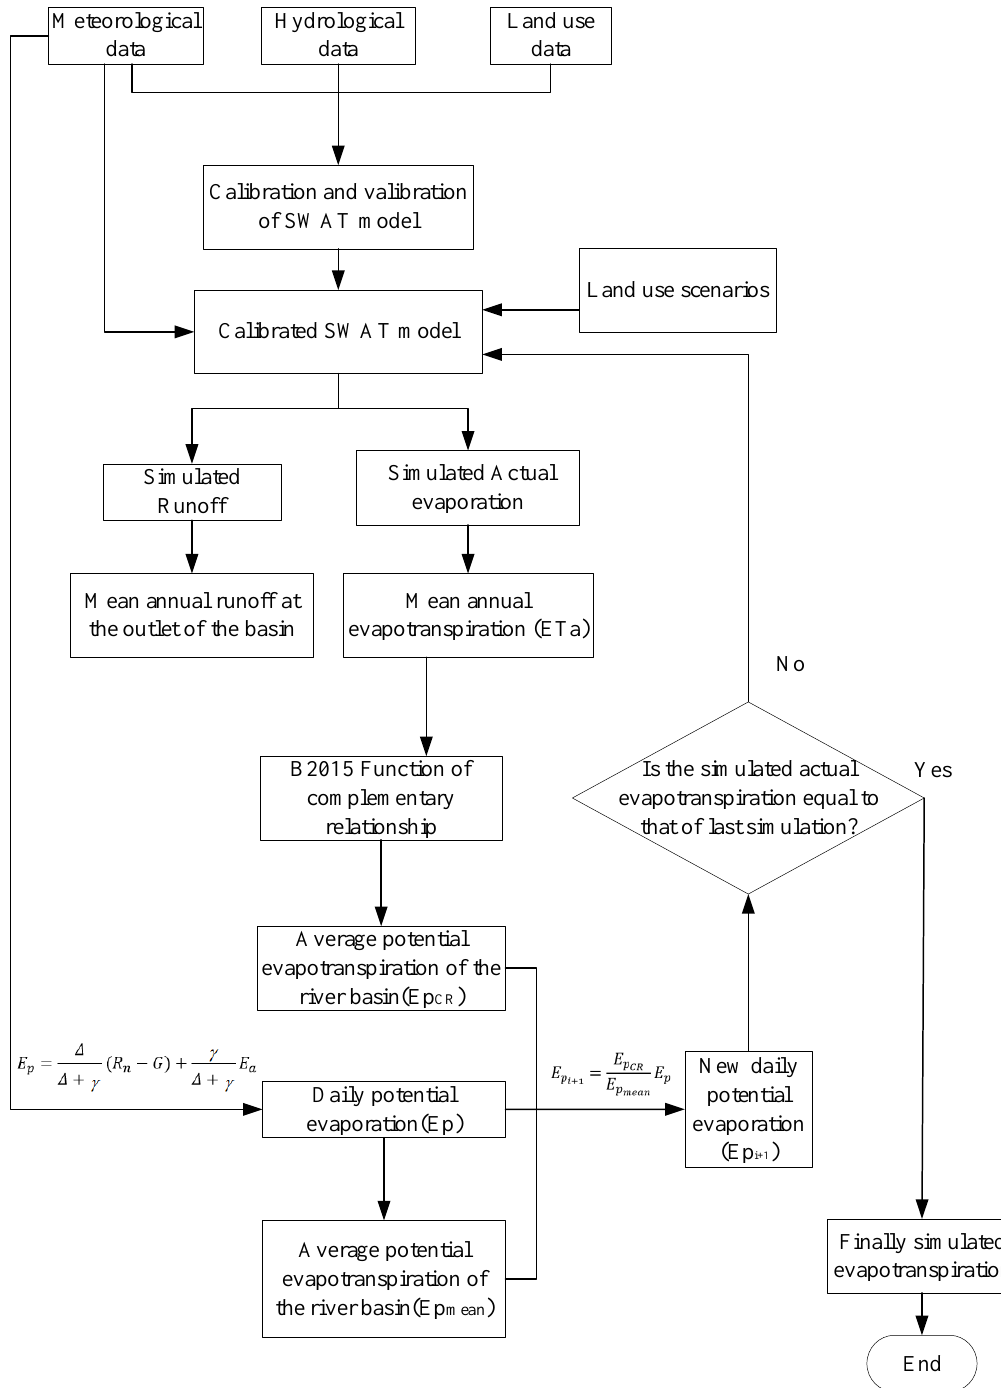
Figure 3. The modeling framework of iterative calculation of the SWAT model coupled with the evapotranspiration complementary relationship.